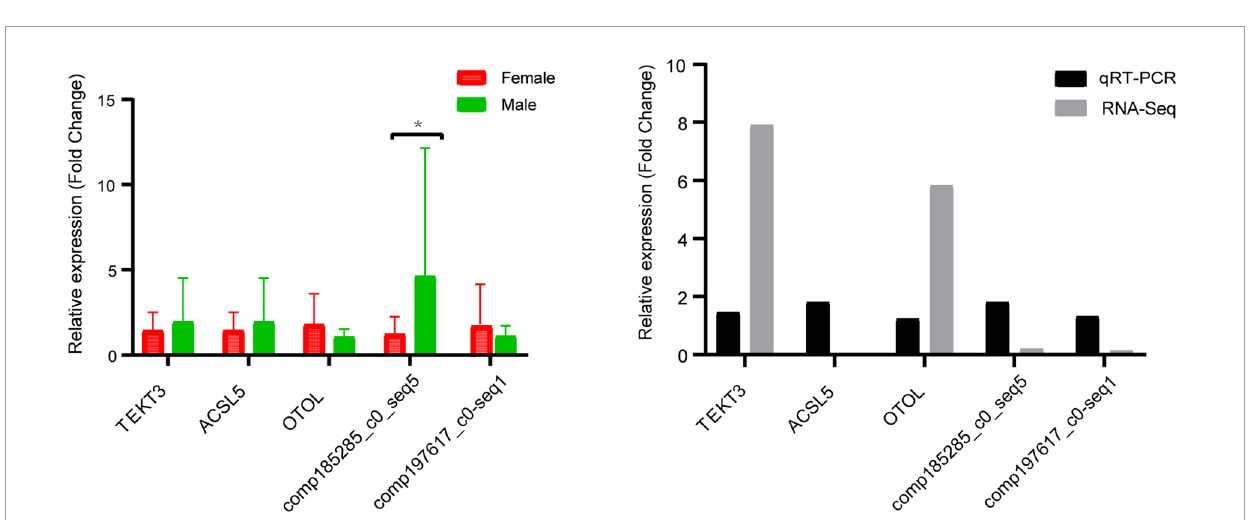
FIGURE6 Quantitative real-time PCR (qRT-PCR) validation of transcriptome data. The X and Y axis represented gene name and the relative expression level of RT-qPCR, respectively. All data represented the average of three student replicates. Error bars indicated the standard error of three replicates. *Significant level p <